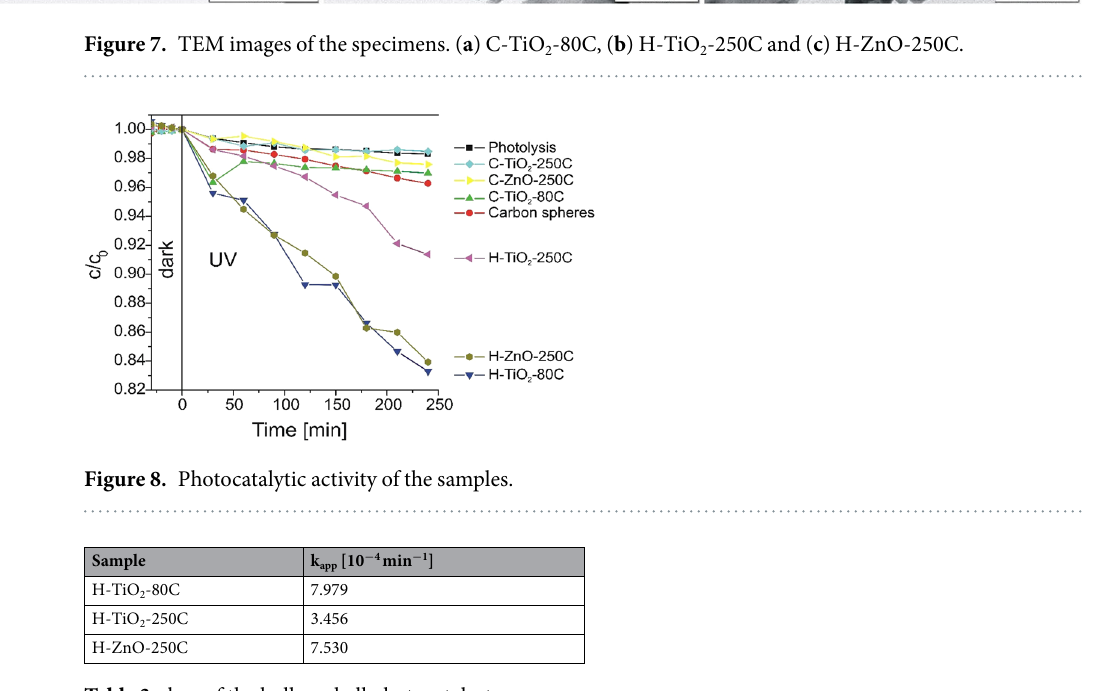
Table 3. k app of the hollow shell